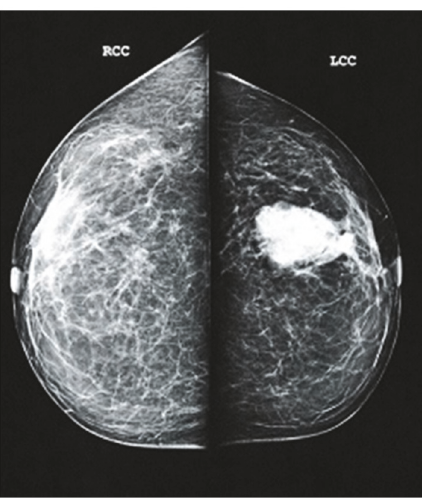
Figure 1: Mammography demonstrates a stable oval, circumscribed mass in the medial part of the left breast.